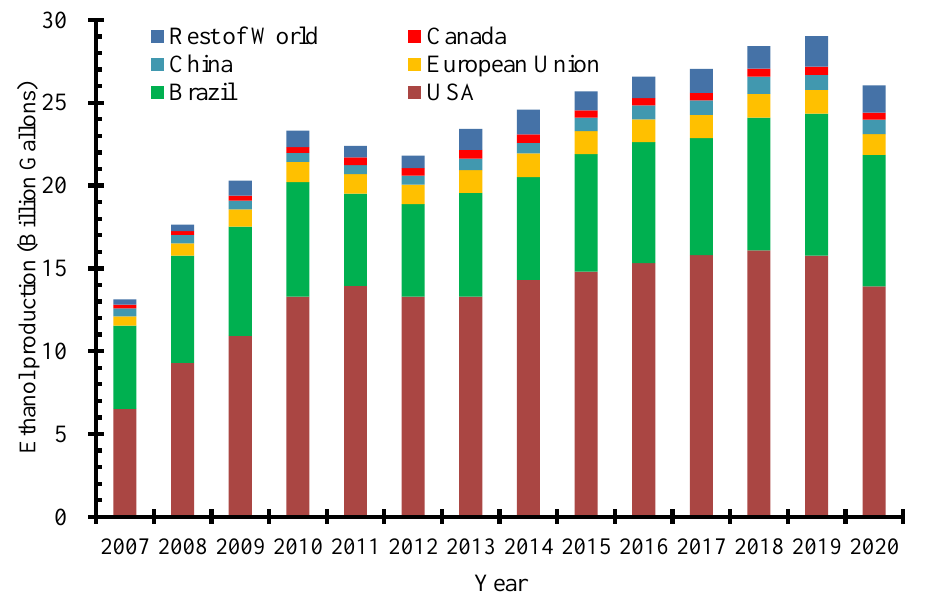
Figure 5. Global ethanol production (Billion Gallons) from 2007 to 2020.